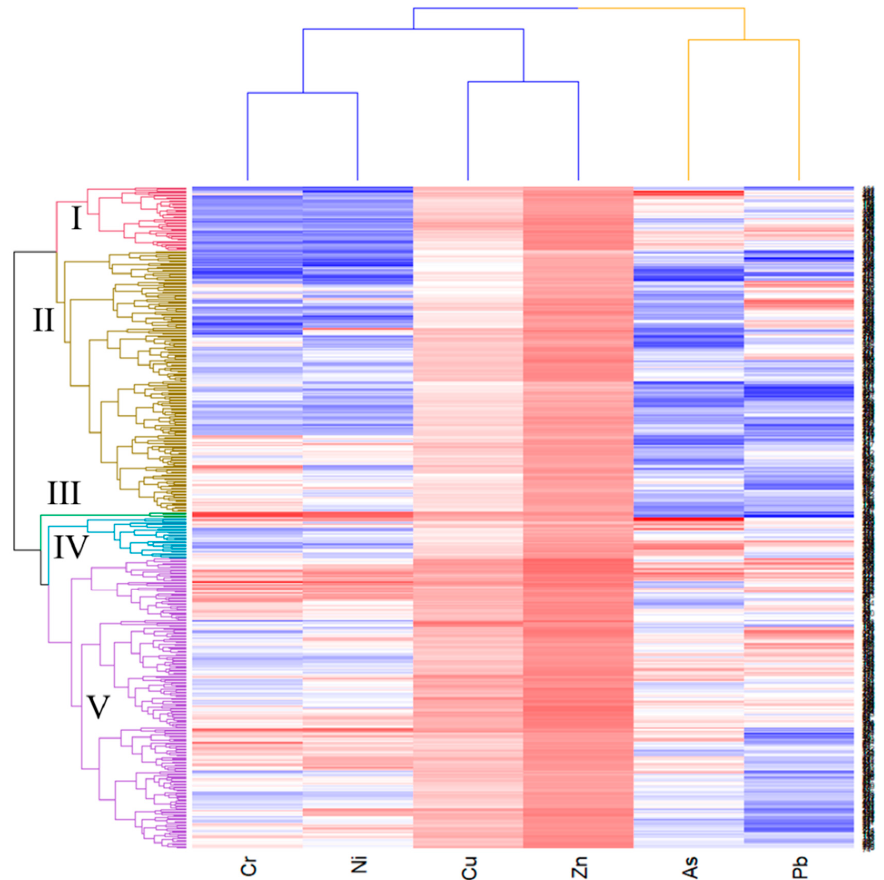
Figure 6. Clustering tree of matrix for cluster analysis of trace metals in the soils of the Golden Triangle.